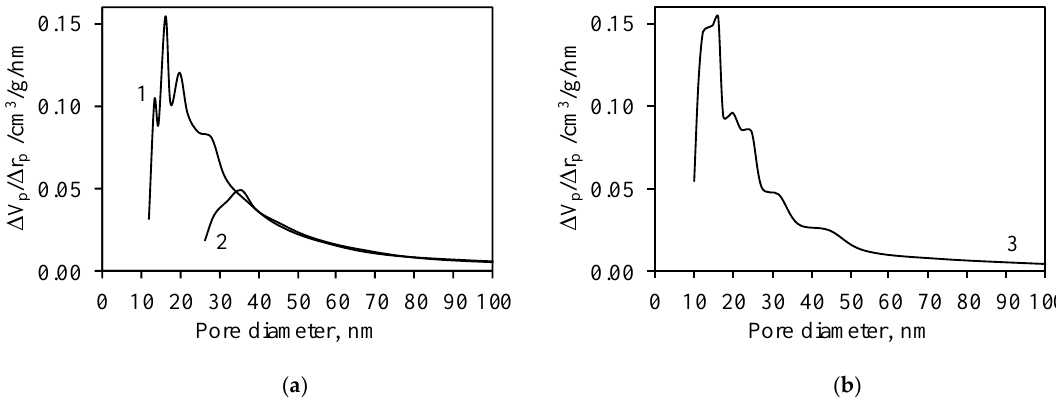
Figure 7. Differential distributions of pore sizes of synthetic ( a ) and calcined ( b ) samples. Here, curve 1 and curve 3 values were obtained by using the model of cylindrical-like pores, and curve 2 values were obtained by using the model of slit-like pores.